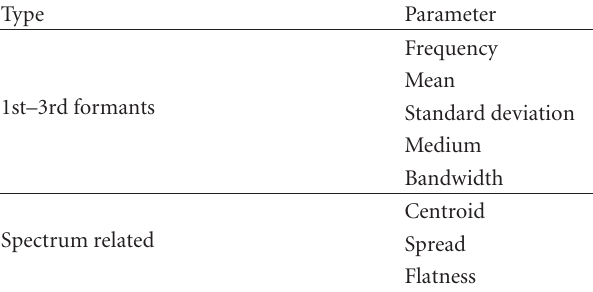
Table 1: Timbre features.